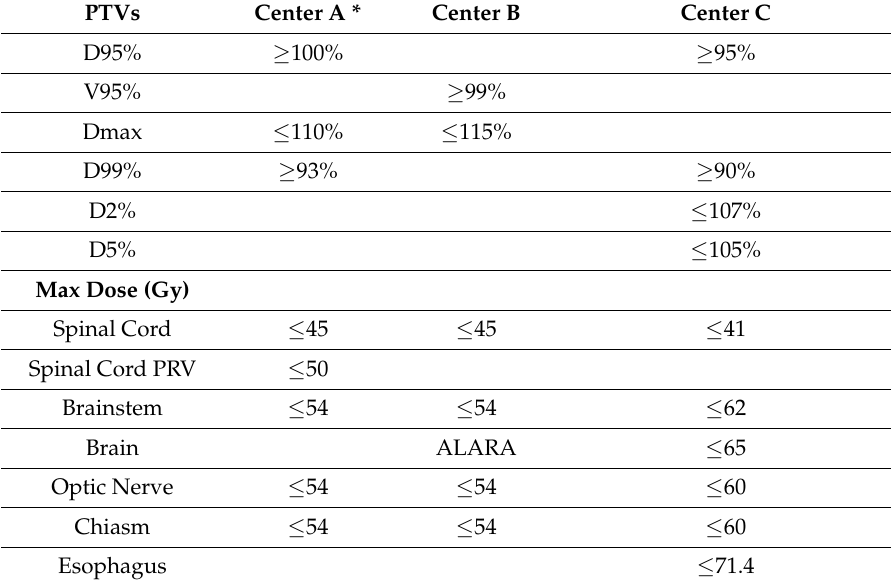
General planning-aims for the three external centers. * : Center A constraints for organs-at-risk (OARs) are on OARminusPTV delineations. We report dosimetric results based on entire OAR